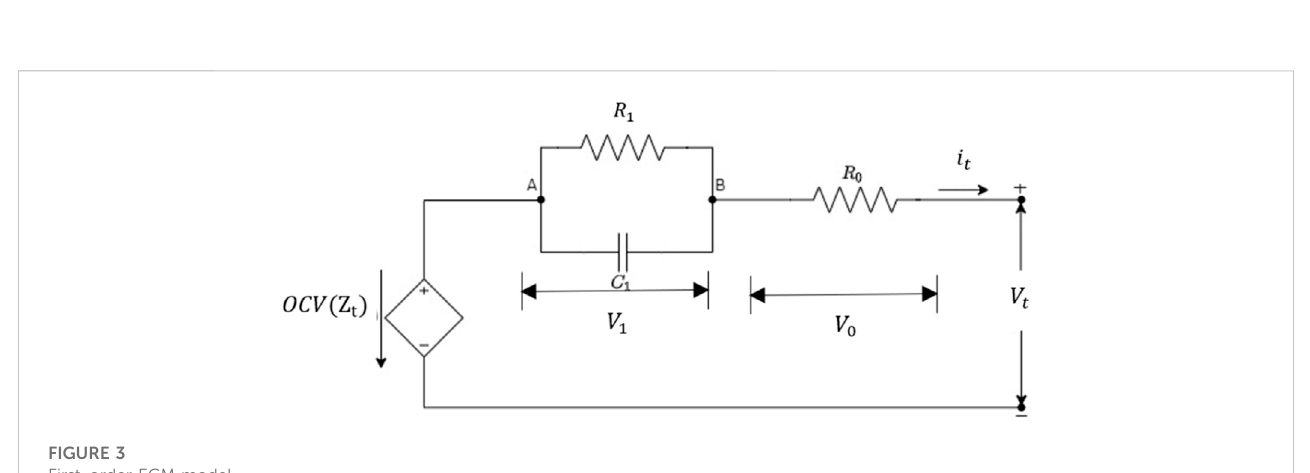
FIGURE 3 First-order ECM